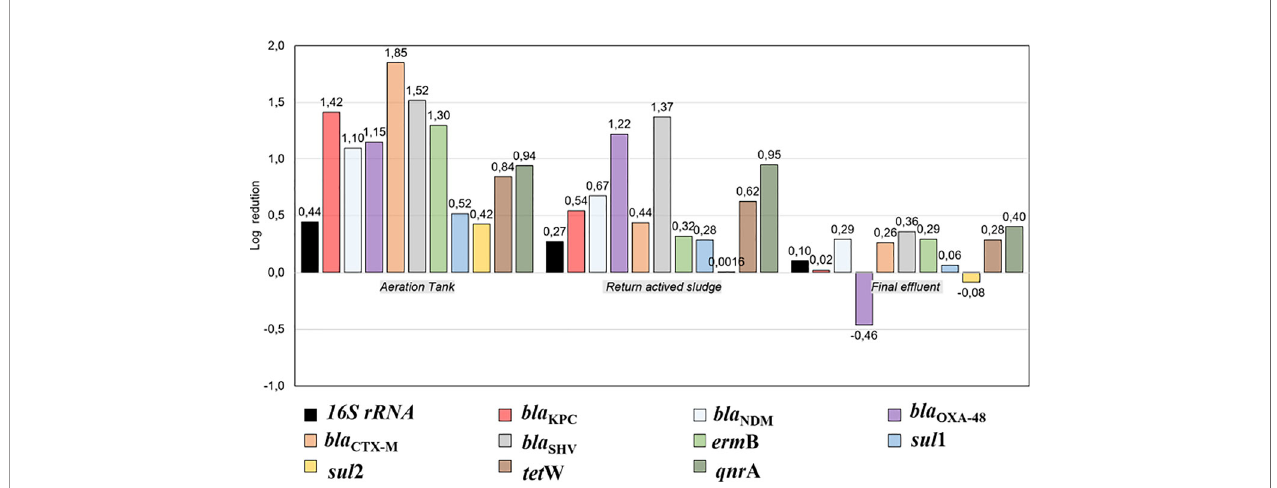
FIGURE 4 | Reduction of concentration of 16S rRNA and ARGs in the stages of the WWTP in comparison with raw in fl uent [average log reduction = log 10 (mean gen copies in fl uent)/(mean gen copies in respective WWTP stage)]. RI, raw in fl uent; AeT, aeration tank; RS, return activated sludge; FE, fi nal ef fl